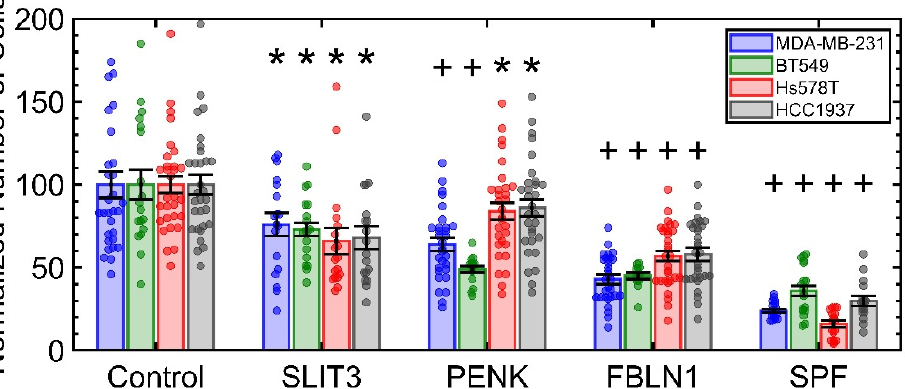
Figure 1. Each of the recombinant proteins induces growth suppression in all four TNBC cell lines. Their cocktail (SPF) induces higher growth suppression, which suggests an additive effect. All statistics are computed in reference to the control. Each condition had a minimum of six replicates with at least two fields of view per well imaged. * p -value < 0.05 and + p -value < 0.001.